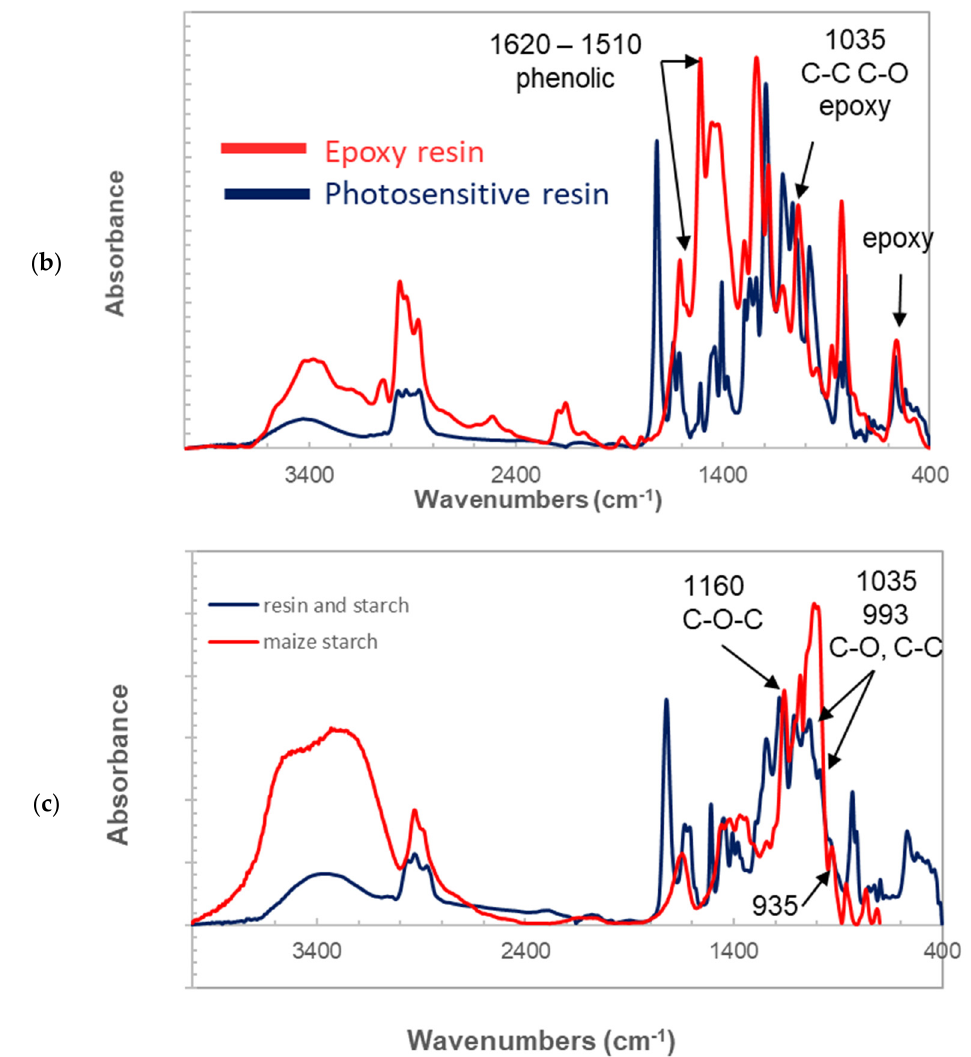
Figure 3. Analysis of photosensitive resin composition ( a ) Infrared spectrum of as-received photo- sensitive resin with band width assignment, ( b ) comparison between as-received and epoxy resin spectra, ( c ) testing experiments showing the setup with high-speed camera monitoring and ruptured specimens for selected composites.